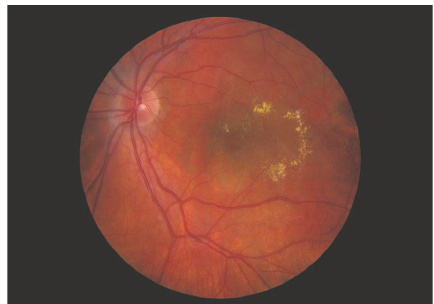
Figure 1: Fundus photograph of the left eye showing central exudation and intraretinal hemorrhages in the temporal macula.